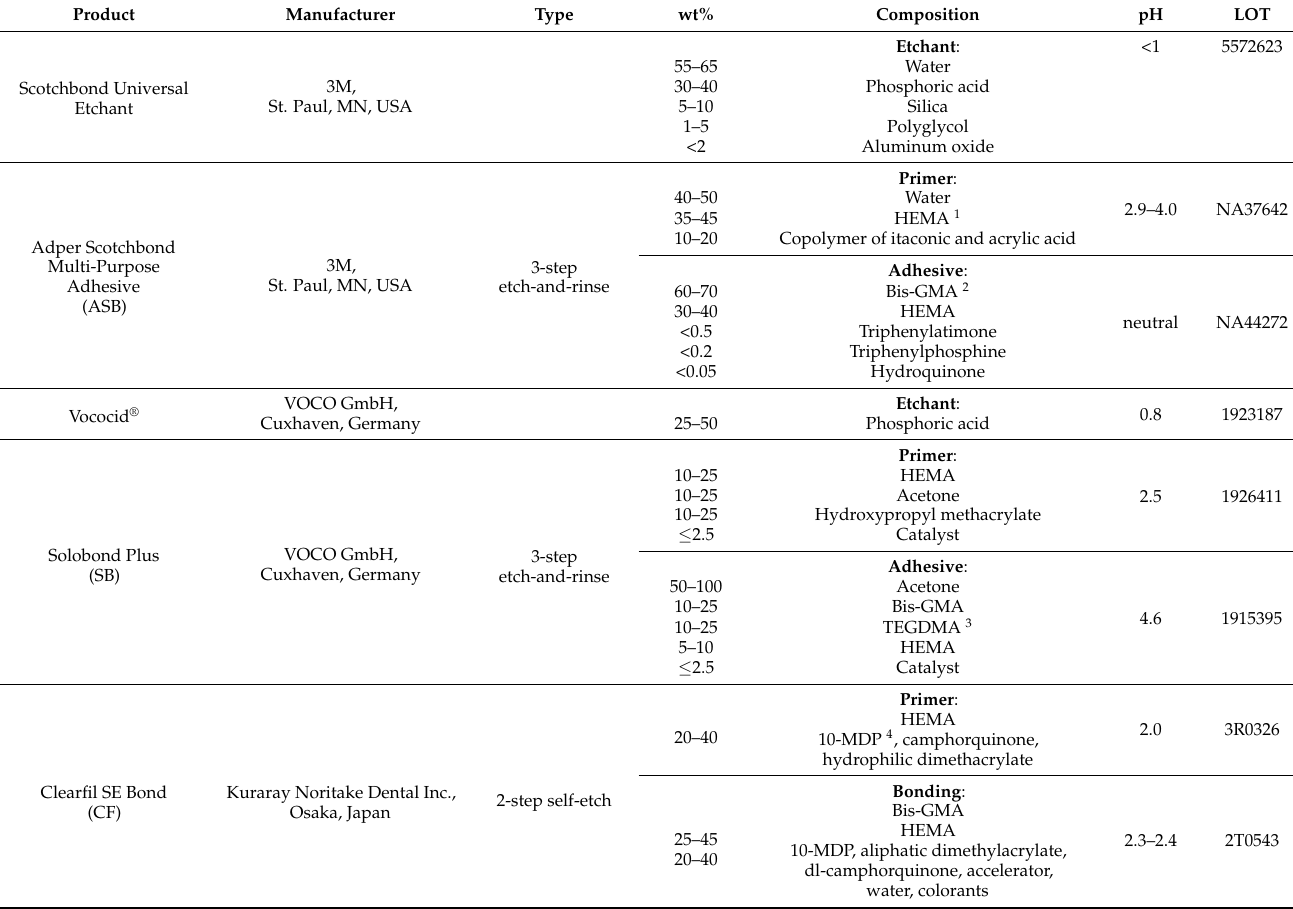
Table 1. Composition of the adhesive systems used in this study according to manufacturers’